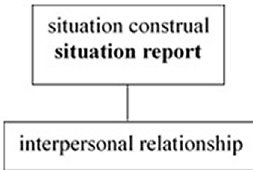
Figure 1. English as a public-self-centered language.